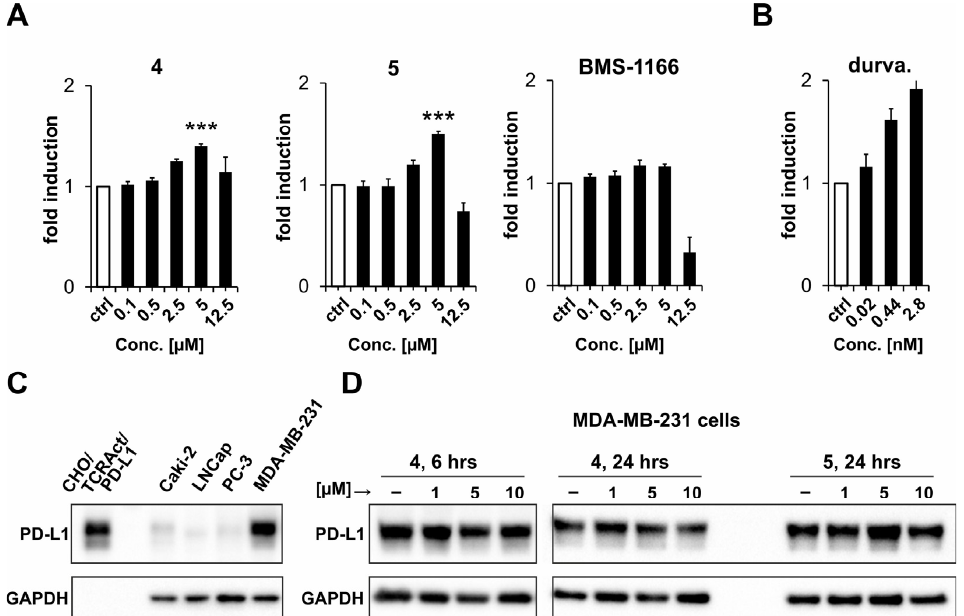
Figure 2. Bioactivity of the indicated compounds. ( A , B ) The activity was monitored with a cell-based immune checkpoint blockade (ICB) assay. Jurkat ECs were contacted with pre-seeded CHO/TCRAct/PD-L1 cells in the presence of the indicated concentrations of the compounds ( A ) or durvalumab ( B ) as a positive control. The cells were co-cultured for 6 h and the luminescence signal was measured following the addition of the Bio-Glo substrate. The graphs show fold induction calculated versus either DMSO-treated (for small molecules) or untreated (for durvalumab) control (ctrl) cells. The results are mean ± SD from three independent experiments. For statistical analysis, Student’s t-test was performed: ***, p < 0.001 vs. BMS-1166 treated cells. ( C ) Analysis of the expression of PD-L1 in four human cancer cell lines compared to PD-L1-overexpressing CHO/TCRAct/PD-L1 cells. ( D ) Analysis of the expression of PD-L1 in MDA-MB-231 cells treated with either 4 or 5 compounds for 6 or 24 h.